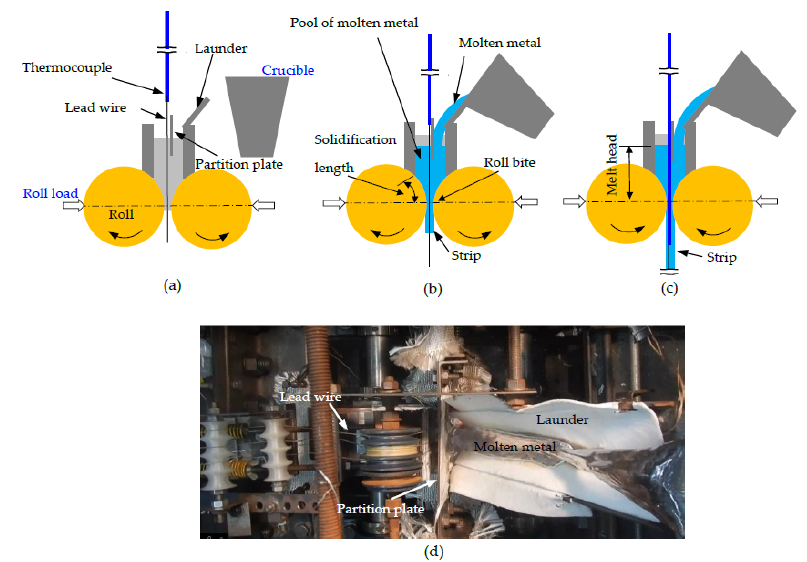
Figure 1. Schematic showing how the thermocouple was inserted into the molten metal pool and incorporated into the strip during casting: ( a ) rolls are rotating at a designated speed, and a lead wire is set between the rolls; ( b ) strip drags the lead wire; ( c ) thermocouple passes through the molten metal pool and is incorporated into the strip. ( d ) Photograph of ( b ) from overhead.